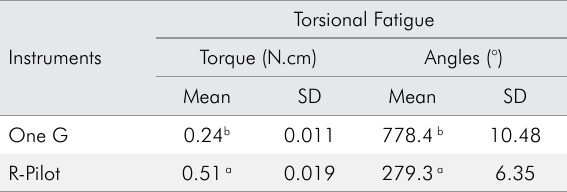
Table 1. Mean values of torque (N.cm) and angle of rotation (°) of the instruments tested.